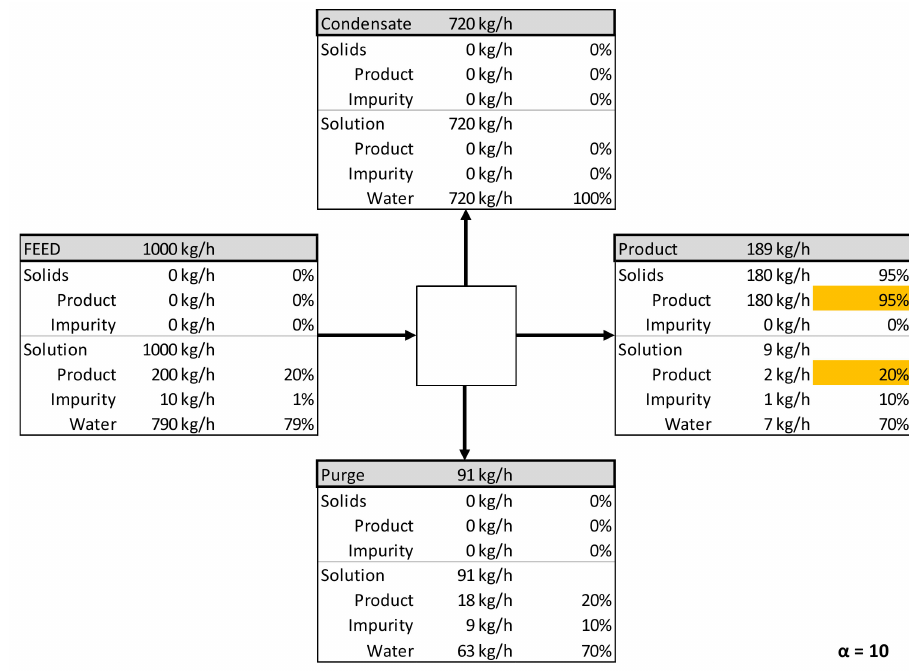
Figure 10. Simplified block balance of an evaporative crystallization process (concentration factor of 10).